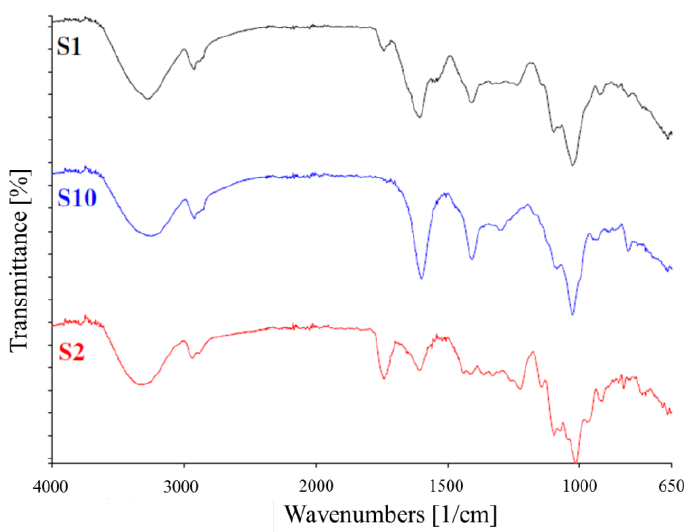
Figure 4. Representative FTIR Spectral patterns of pectin (S 2 ), alginate (S 10 ) and P/A/WP (S 1 ) films.